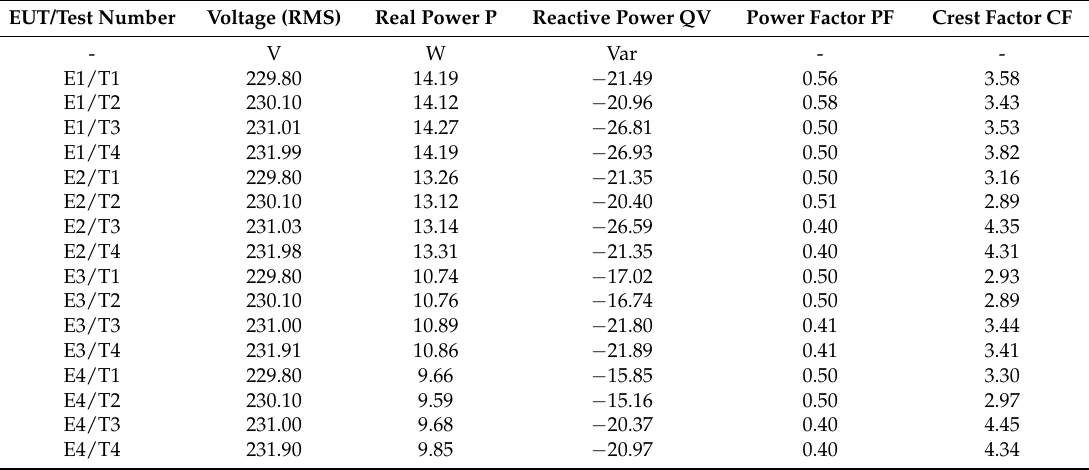
Table 6. Measurement results of electrical parameters of LED lighting sources.